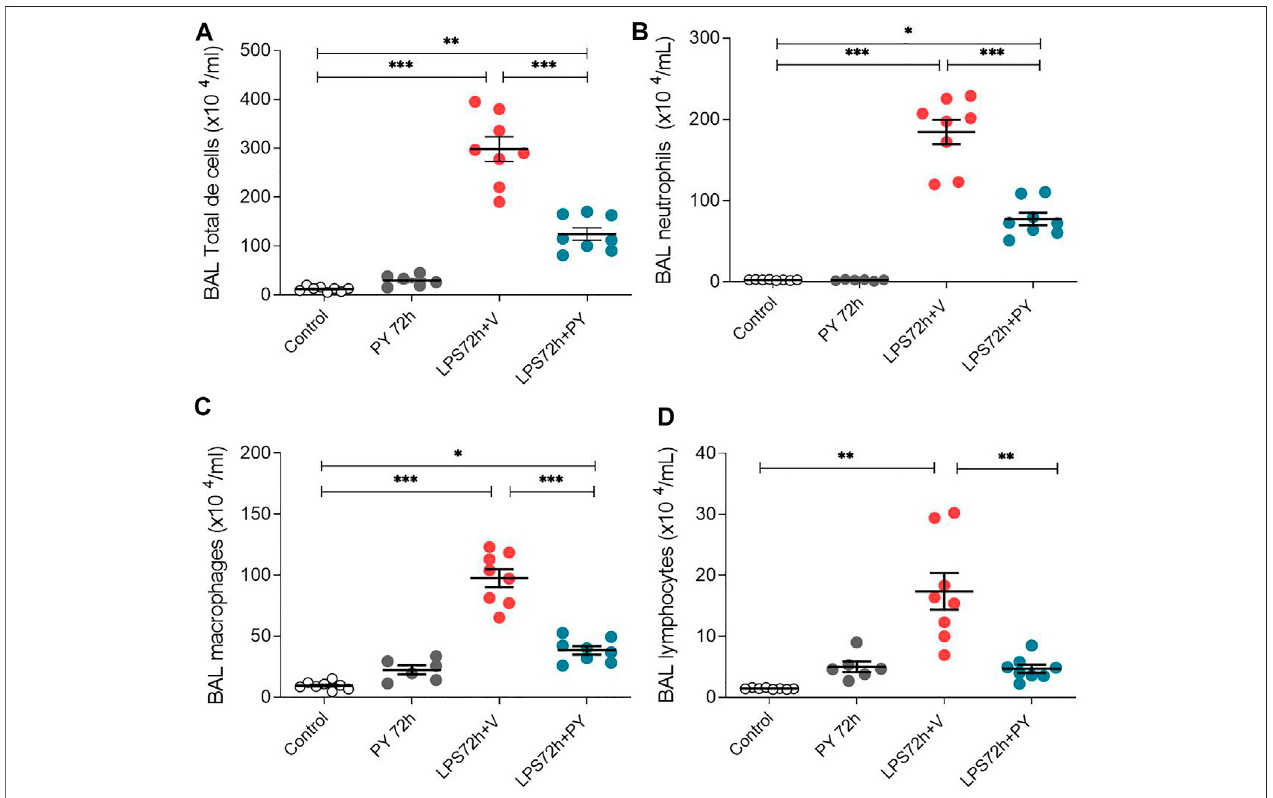
FIGURE 2 | Pyridostigmine reduces BAL immune/in fl ammatory cell numbers in LPS exposed mice at 72 h. (A) BAL total cells (B) neutrophils, (C) macrophages, and (D) lymphocytes. Vehicle (V) group (Control), pyiridostigmine (PY), lipopolysaccharide (LPS) *** p < 0.001, ** p < 0.01 and * p < 0.05. Values expressed as mean ± SEM. One-way ANOVA followed by Tukey ’ s test (See text for